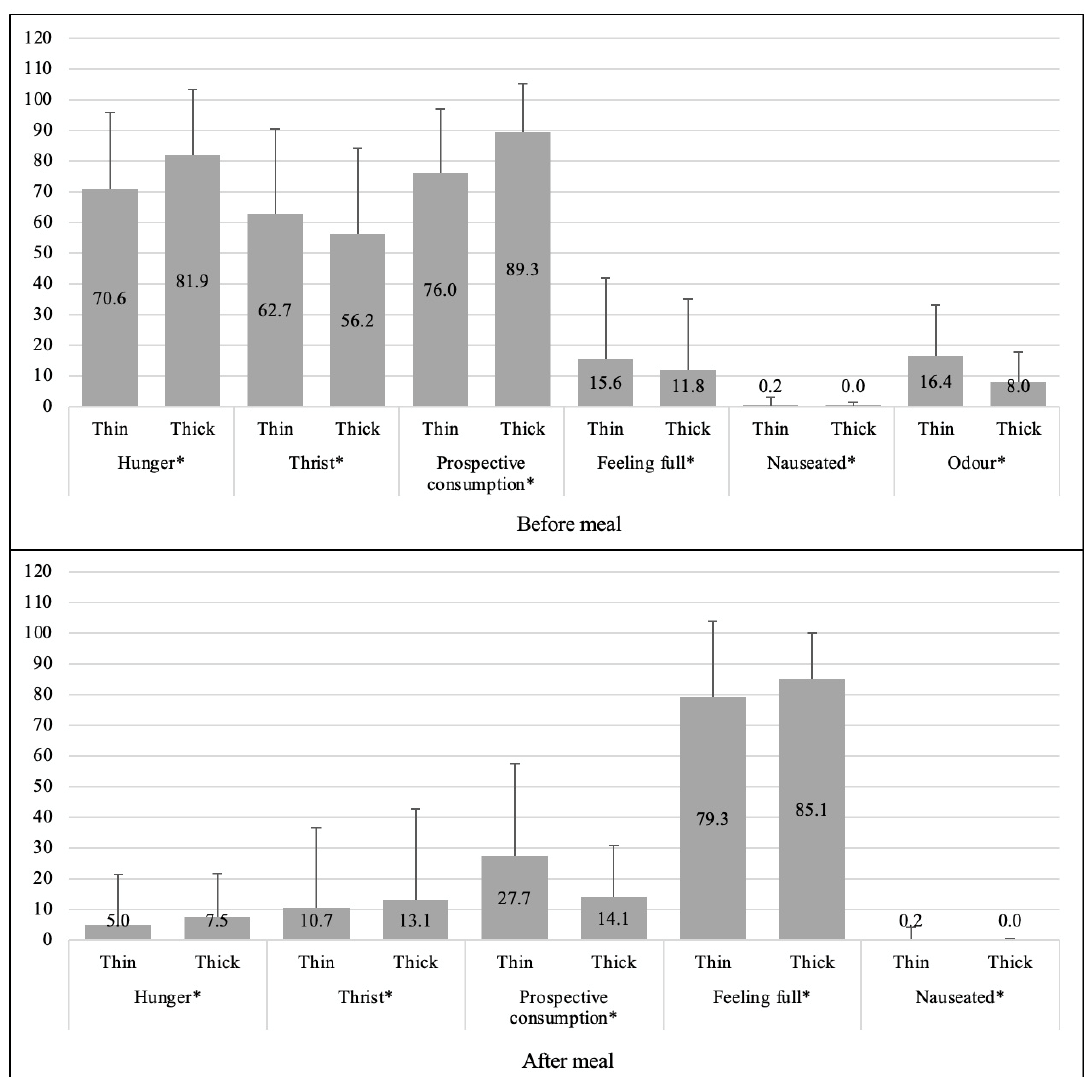
Figure 3. Mean ± SD differences of Visual Analog Scales (VAS) variables between thick and thin daal preparations before and after the meals (N = 100). Ratings of VAS scores: 0–100 mm, highest score = extremely happy, lowest score = not at all happy. The difference of VAS scores between thin and thick preparations of daal before and after the meals shows that in relation to thin and thick daal , preferences were significantly different for all VAS variables. This means adolescent girls had different preference in regard to thin and thick preparations of daal with respect to the parameters hunger, thirst, prospective consumption, feeling full, and feeling nauseated. * Independent sample t test significant at p < 0.05.